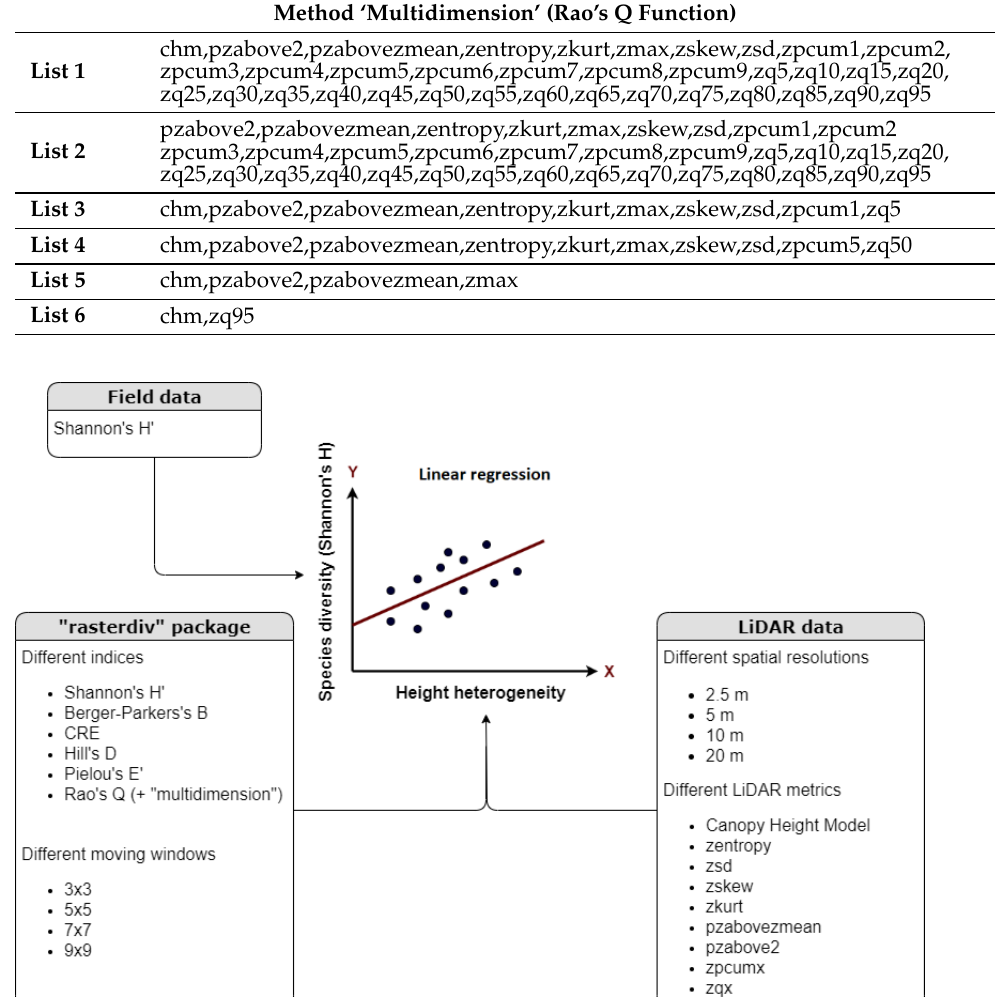
Table 3. Composition of the lists used in the “multidimension” method of Rao’s Q function ( rasterdiv ).